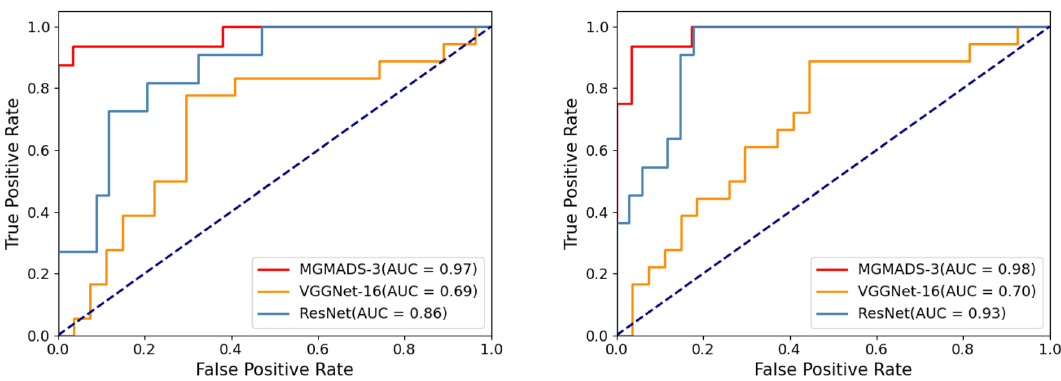
Figure 11. ROC analysis curves of different models in X-ray and CT